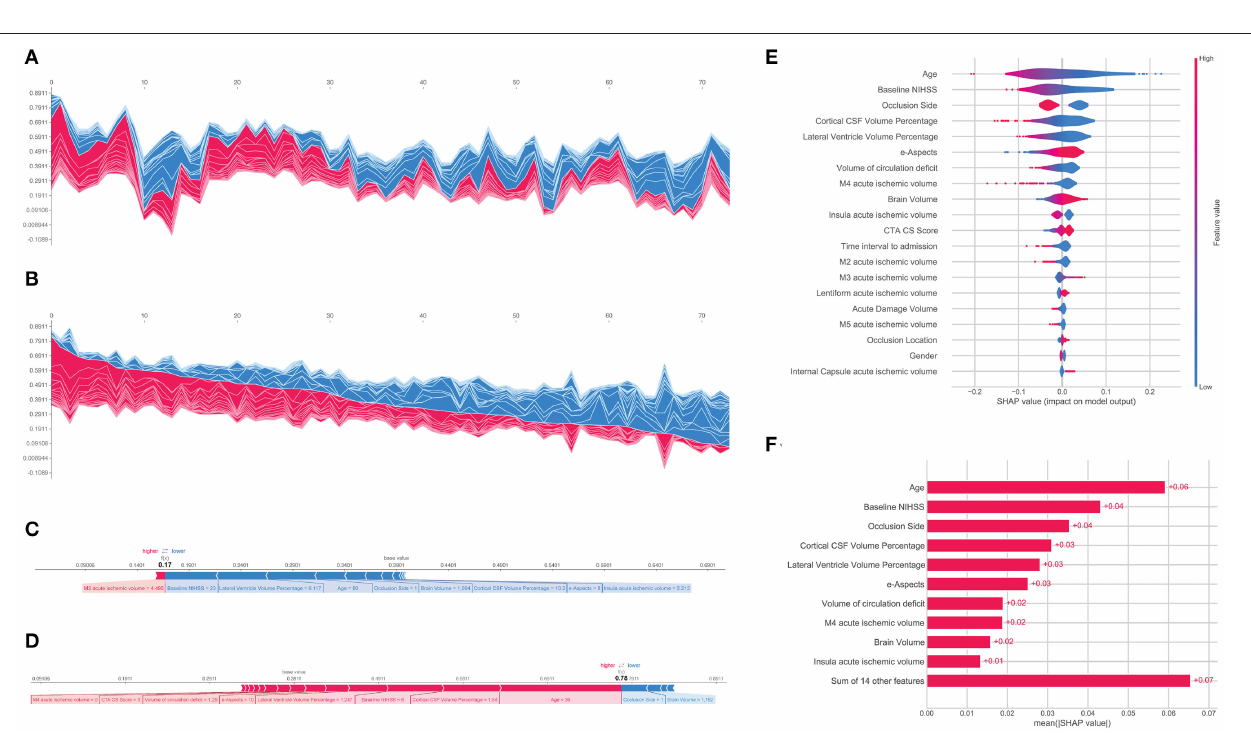
FIGURE 3 | Shapley Additive Explanation (SHAP) force plot of the testing set with the vertical axis representing model outcome and the horizontal axis representing the testing population sample ordered by feature similarity (A) and by model output (B) . Examples of the model output for an individual patient with the determining feature values that influenced the classification decision from the poor outcome group (C) and the favorable outcome group (D) . SHAP summary plot showing the distribution of each patient feature and how it affects the model outcome through its SHAP value (E) . Absolute mean SHAP values for the global effect of every feature effect on the model output (F)